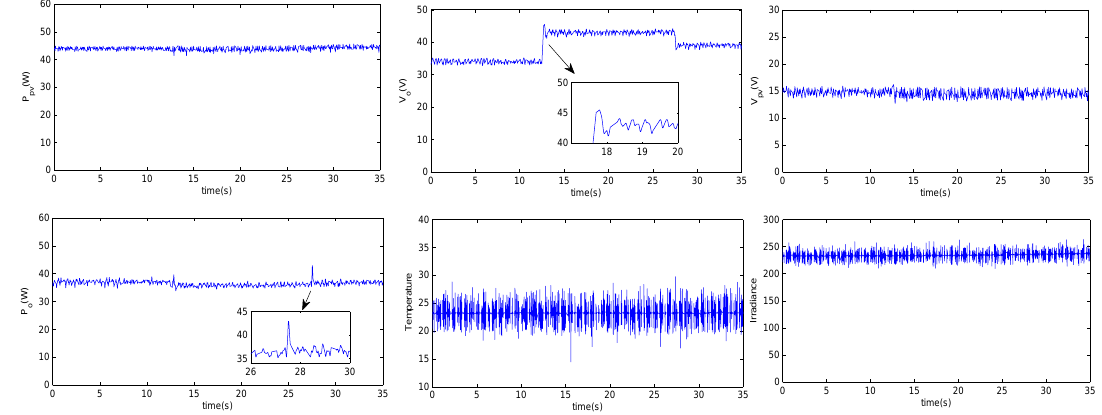
Figure 14. Real behaviors of P pv , P Load , V Load , and V pv using two-stage MPPT